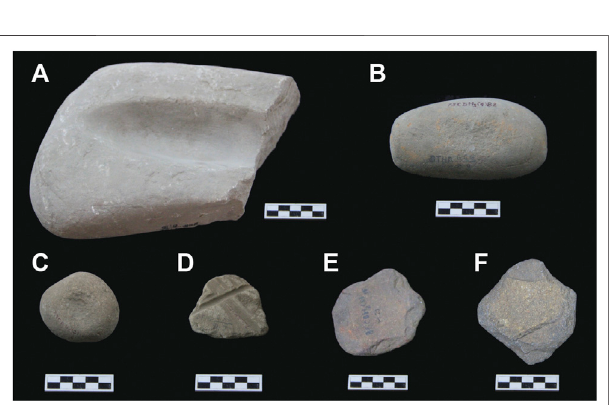
FIGURE 3 | Typical stone tools collected from the Cai Beo site (Scale bar:5 cm). (A) Grindingstone, (B) Muller/Pounder, (C) Pittedstone, (D) Stone tool with “ Ha Long Mark ” , (E) Scraper, (F) Pointed